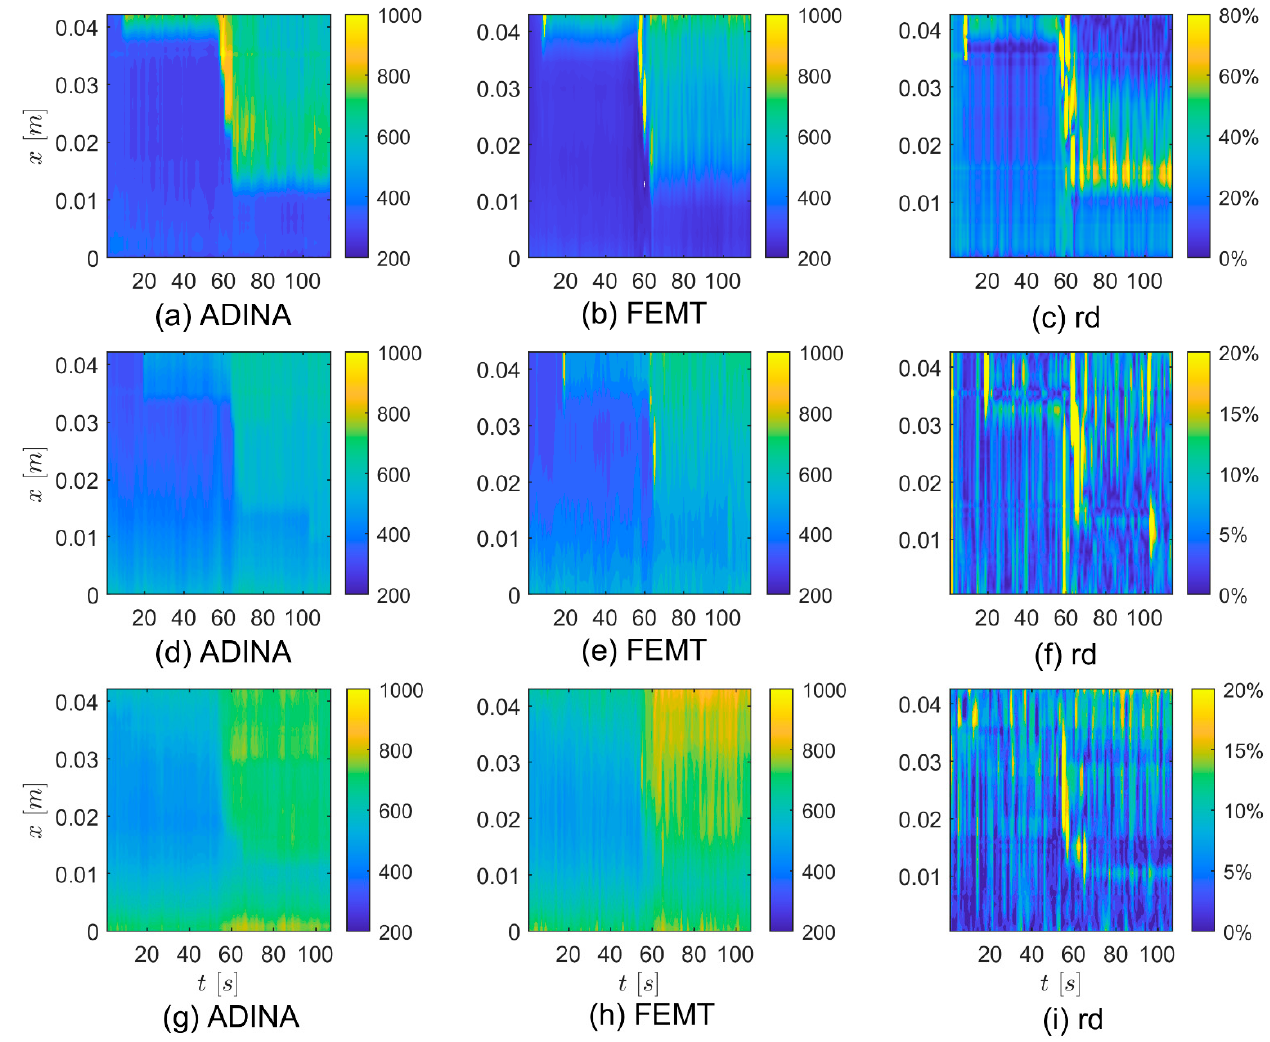
Figure 10. The distribution of the heat transfer coefficient versus coordinate x and time t obtained using ADINA software ( a , d , g ) and FEMT with applying Trefftz functions ( b , e , f ); the relative differences between local heat transfer coefficients as the results of calculations according to these two methods (ADINA and FEMT). The calculations performed on the basis of the results of experiments were performed at three values of mass flow rate: ( a – c ) Q m = 5 [ kg/h ] ; ( d – f ) Q m = 30 [ kg/h ] ; ( g – i ) Q m = 55 [ kg/h ]